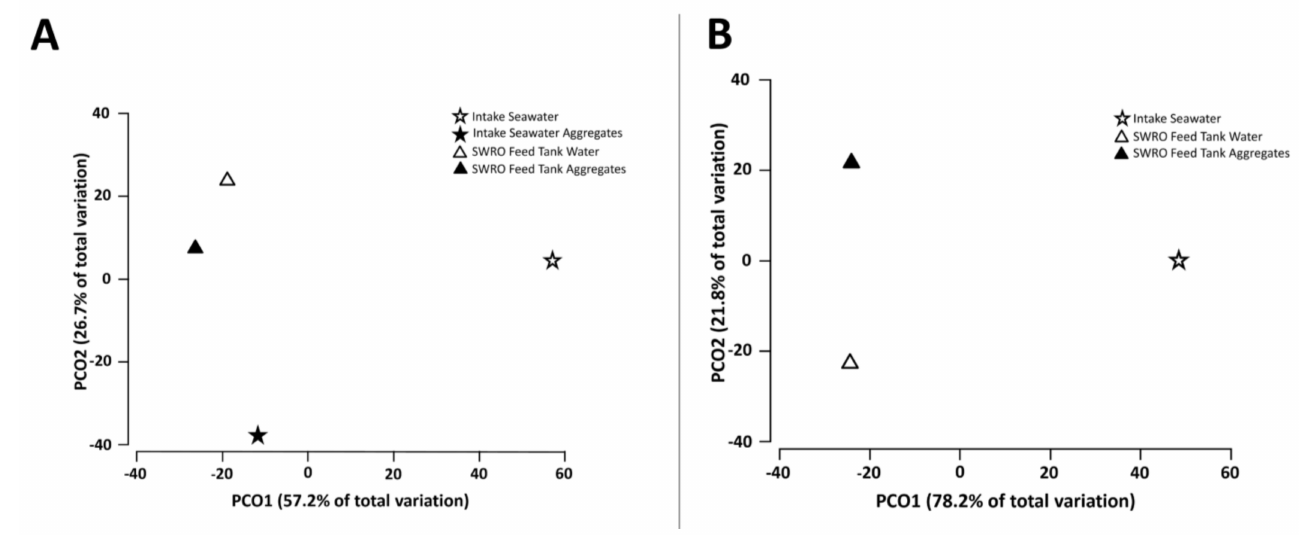
Figure 2. Principal coordinate analysis (PCoA) based on Bray-Curtis distance ordination, displaying the differences in the intake seawater and SWRO feed tank water in ( A ) the prokaryotic communities in the planktonic and aggregate-associated samples and ( B ) eukaryotic communities in the planktonic and aggregate-associated samples. The total variability is explained by the two PCoA axes, with the ordination of water samples, ( A ) explaining 83.9% of the attachment and pre-treatment variability observed in the samples and ( B ) 100% of the variability observed in the pre-treatment and attachment of the